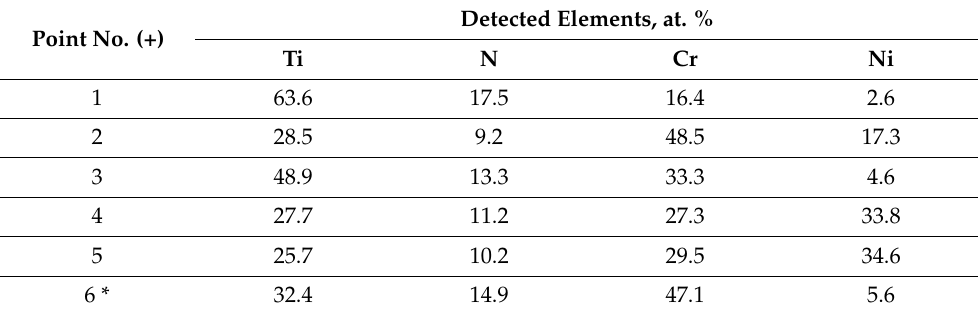
Table 3. Results of the energy dispersive analysis of local regions in the structure of CrNi-TiN powders produced by SHS. Point No. (+)